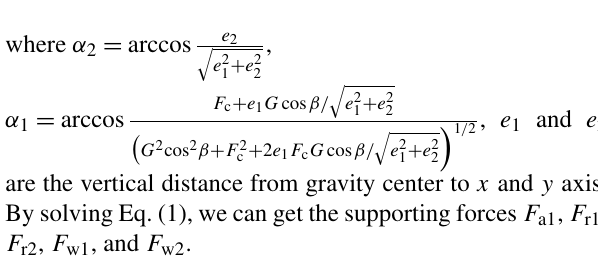
Figure 3. Schematic diagram of circumferential motion in concrete mixing process.